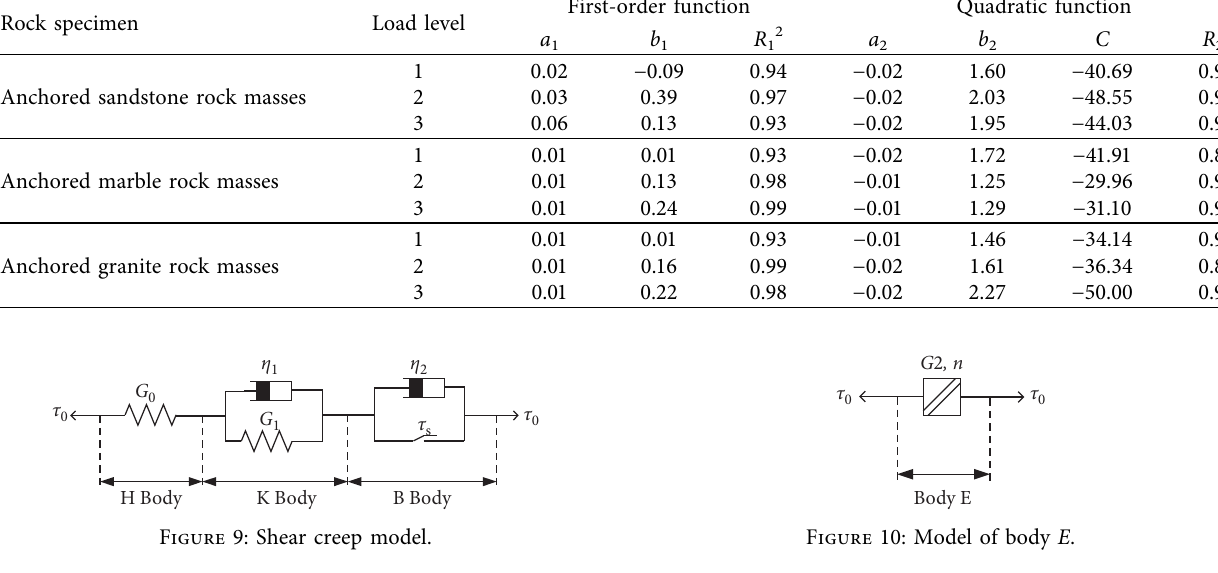
Table 4: Related parameters of fitting curve.